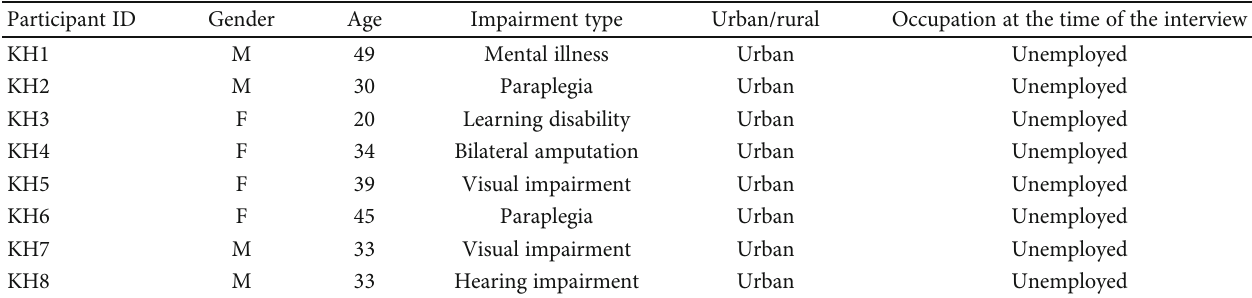
Table 3: Summarised description of participants with disabilities from the urban area of Khomas region that engaged in a focus group discussion ( n = 8 ).